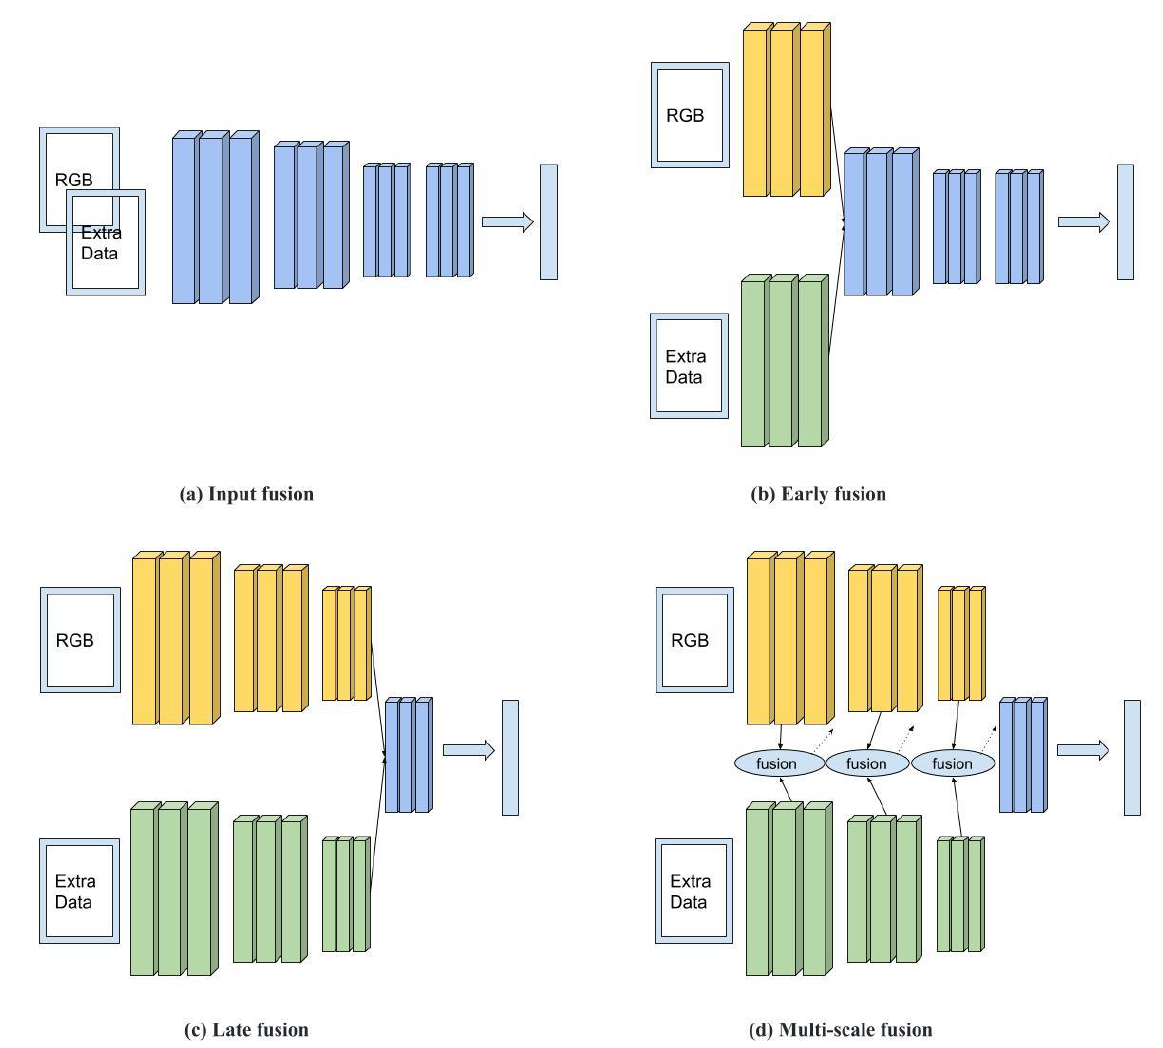
Figure 1. Image data fusion categories.